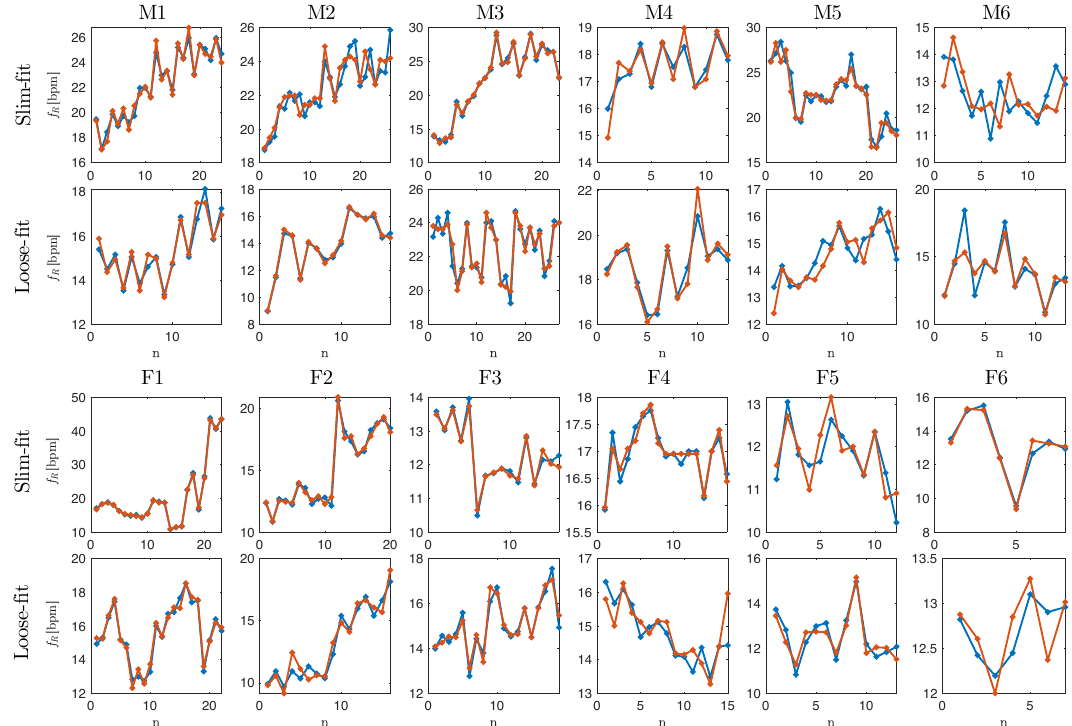
Figure 3. Breath-by-breath values of the respiratory rate collected by the reference system (blue dots and lines) and by the proposed measuring system (orange dots and lines). Data from male (i.e., M1, M2, M3, M4, M5, M6) and female (F1, F2, F3, F4, F5, F6) volunteers wearing slim-fit and loose-fit clothing are reported. Details about MAE, SE and %E values per each volunteer with slim-fit and loose-fit clothing are reported in Table